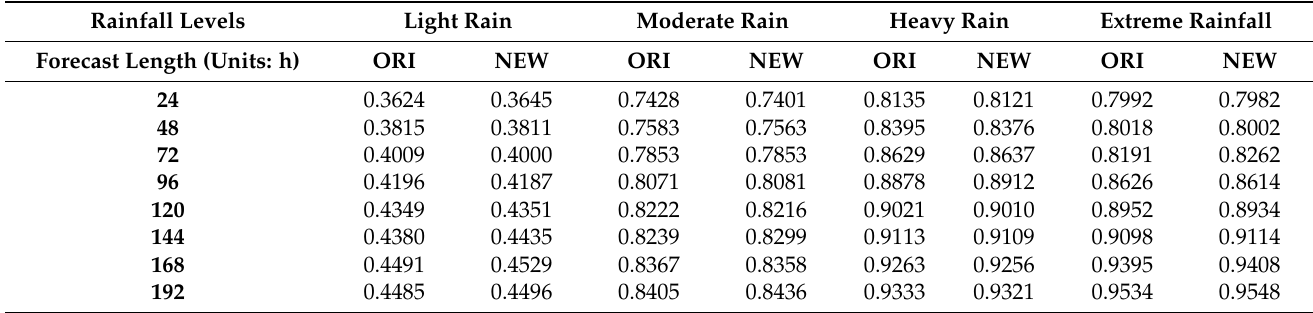
Table 8. POMA of precipitation at different rainfall levels over East